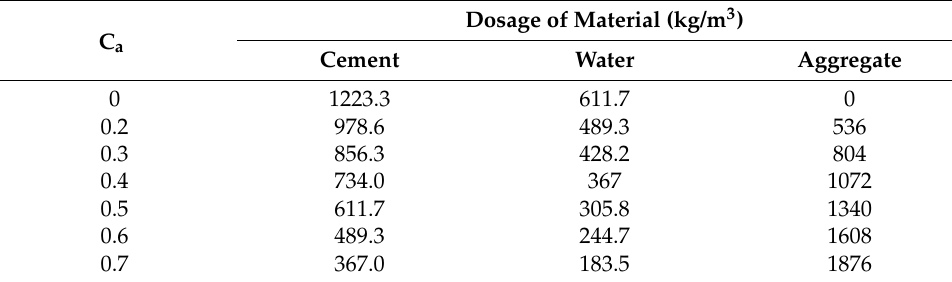
Table 3. Mix proportion of concrete at w/c =